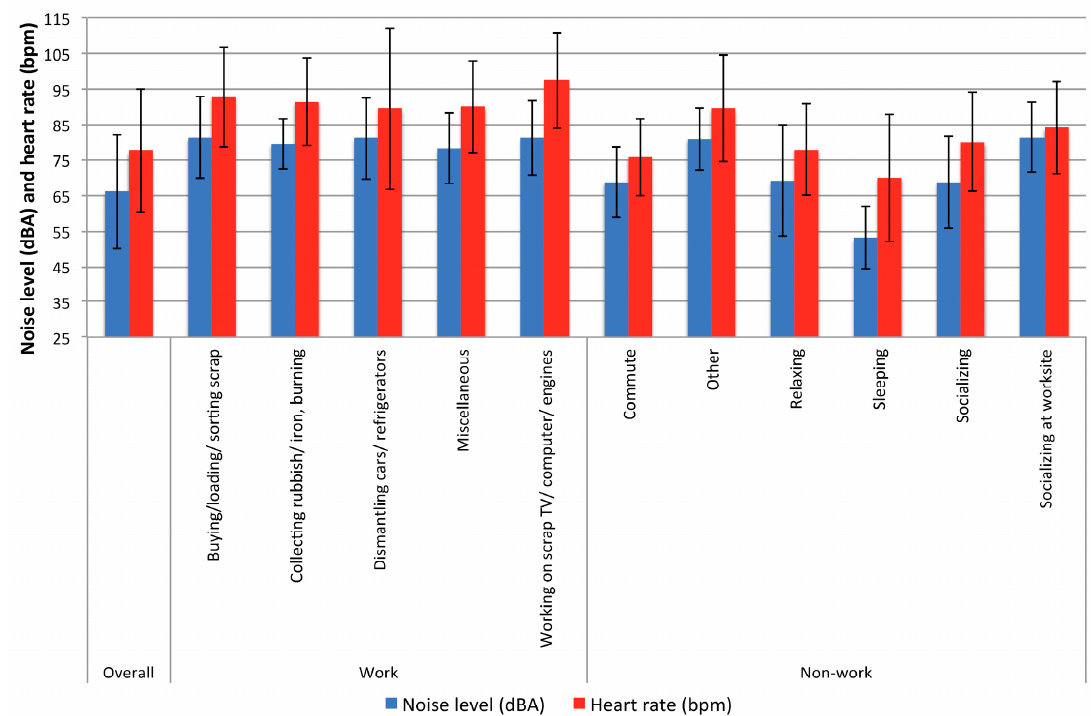
Figure 2. Average noise levels (dBA) and heart rate (bpm) overall and by work and non-work activity ( N = 57 subjects).